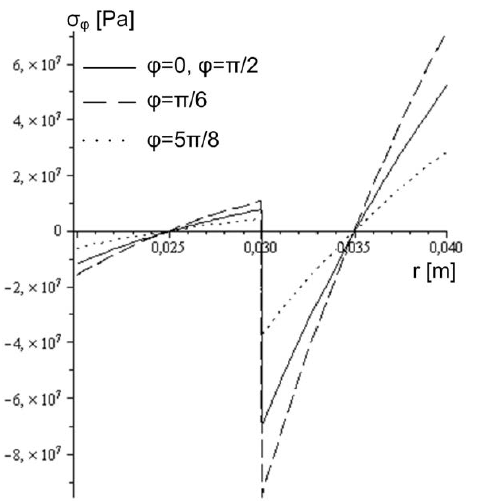
Figure 15: Plots of τ rφ for Example 2.